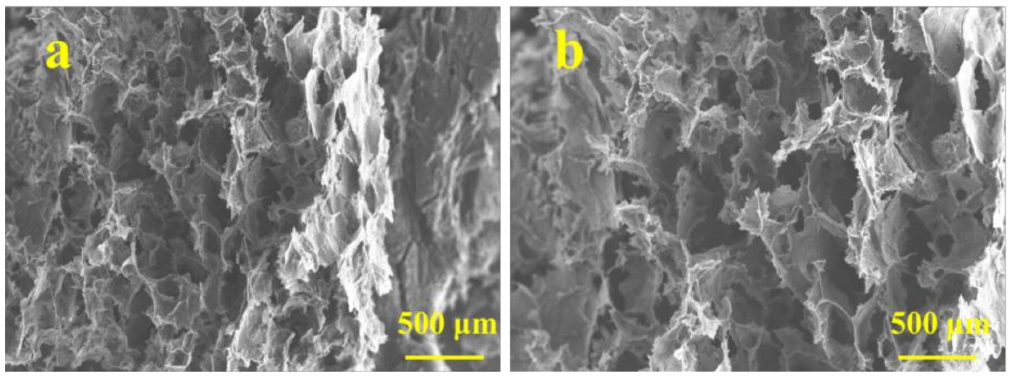
Figure 7. ( a ) SEM image of cross-section structure of graphene/CNTs aerogels; ( b ) SEM image of cross-section structure of graphene/CNTs aerogels after compression for 10 times.